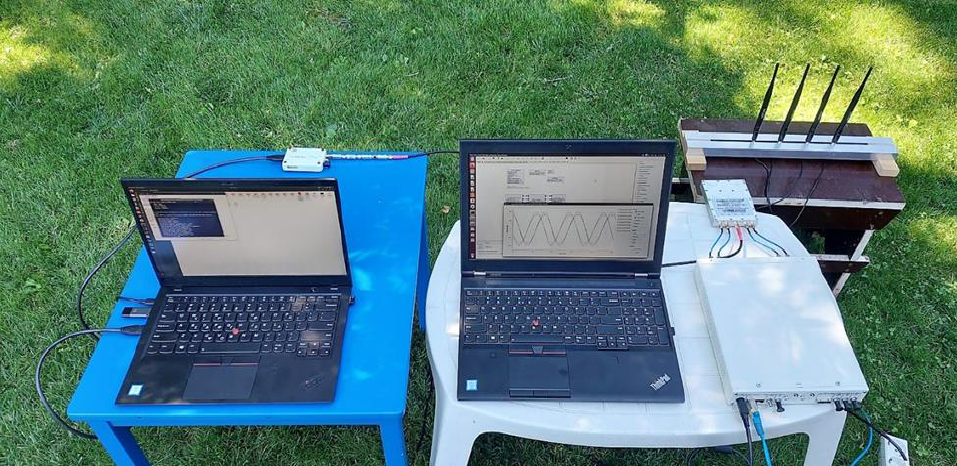
Figure 4. The linear antenna system that was used and the USRP X310 SDR platform during the calibration procedure of the Twin-RX RF modules.